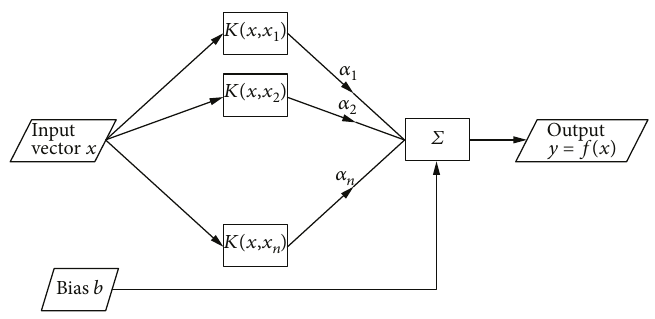
Figure 4: Typical architecture of the nonlinear SVR